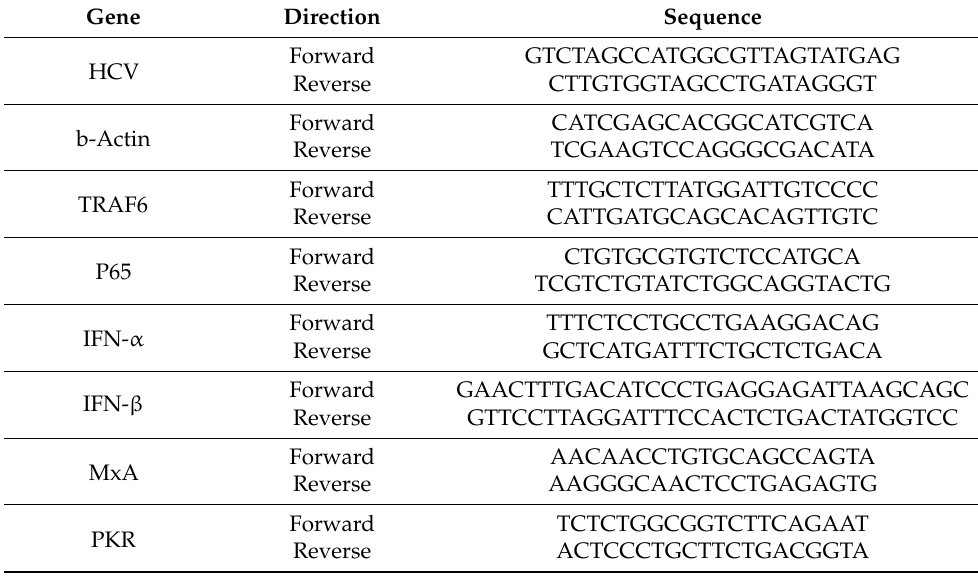
Table 1. List of primer couples generated for